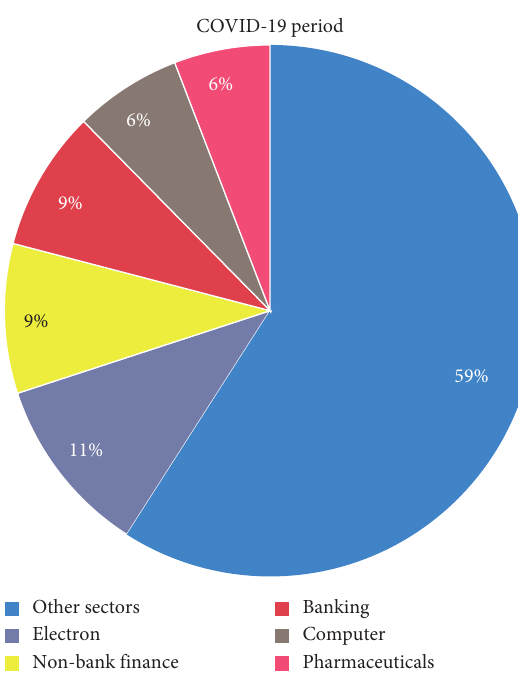
Figure 7: CES in the COVID-19 period